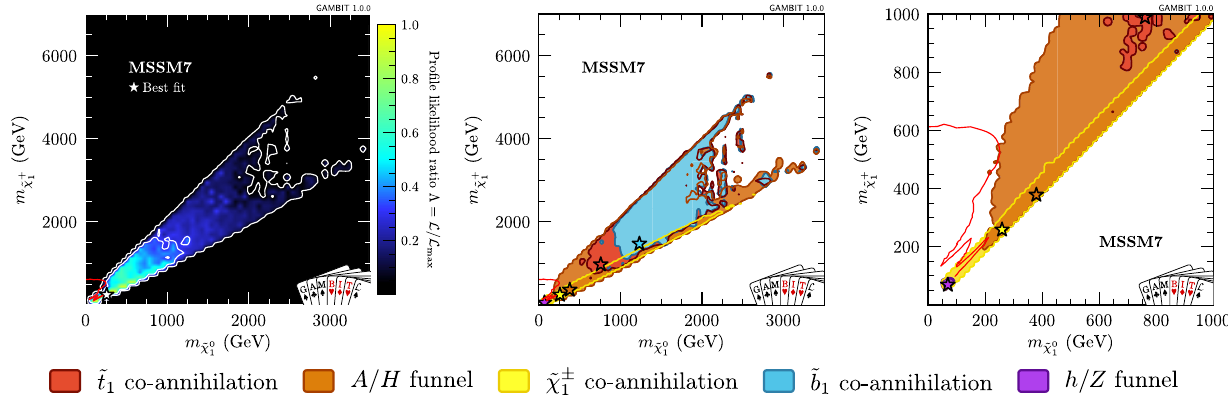
Fig. 7 1D profile likelihood ratios for the masses m ˜ χ 0 the models to obey the relic density constraint